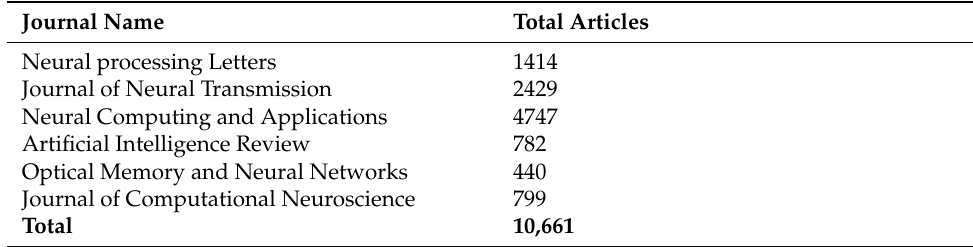
Figure 3. Distribution of articles per year. Table 2. Number of articles per